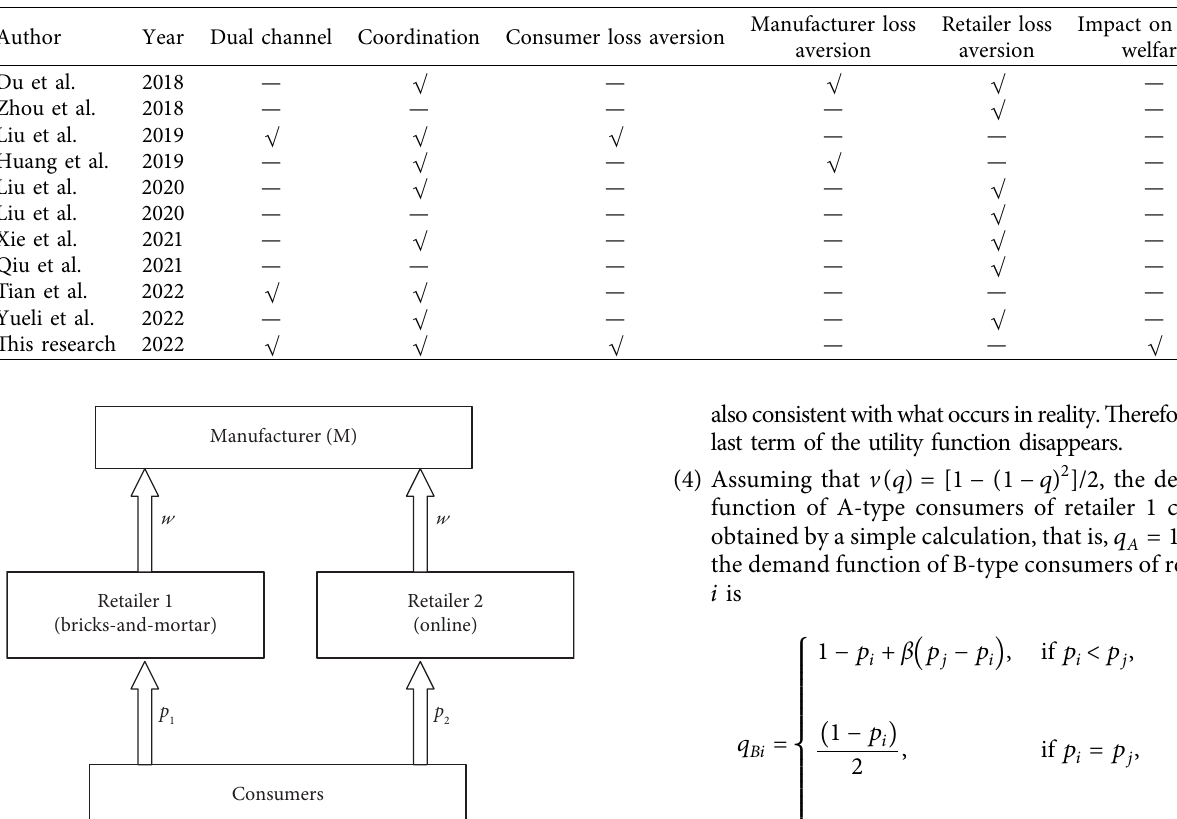
Table 1: Literature comparison.